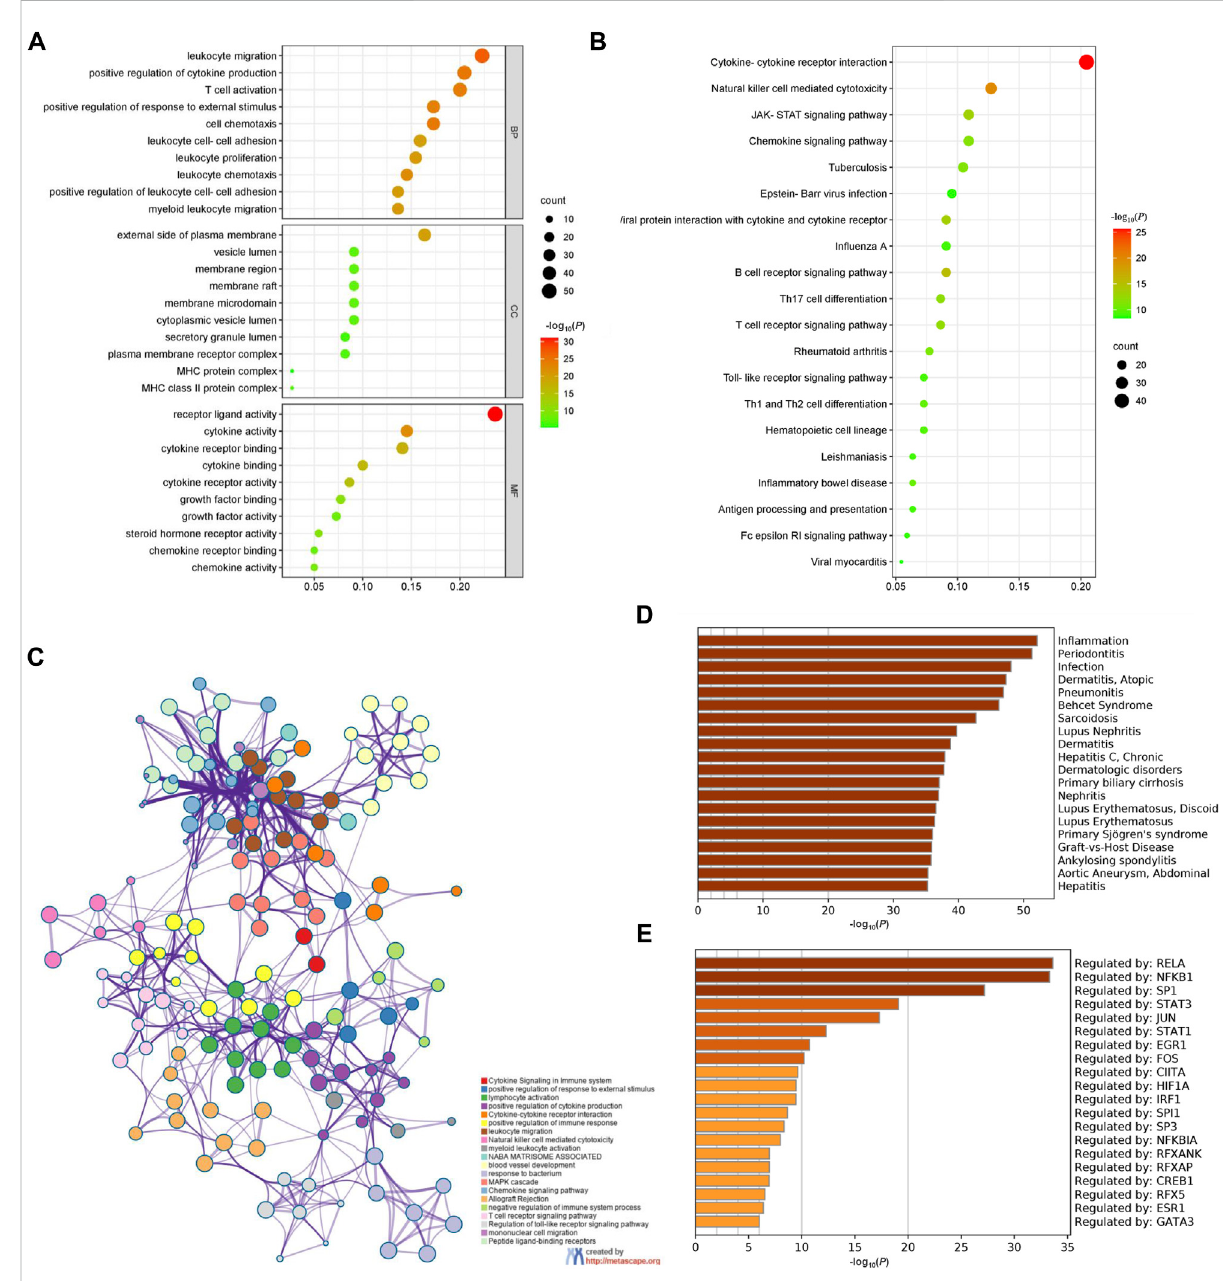
FIGURE 5 EnrichmentanalysisofDEIRGsinCAVD. (A) GOenrichmentanalysis. (B) KEGGpathwayenrichmentanalysis. (C) Thenetworkofenrichedterms andeach noderepresents an enriched term. (D) Summary ofenrichmentanalysisbasedon DisGeNET database. (E) Summaryofenrichmentanalysis based on TRRUST database. The light brown to dark brown gradient indicates an increase in -log 10 ( P ). Count: the number of genes enriched in each term; DEIRGs, differentially expressed immune related genes; GO, gene ontology; KEGG, kyoto encyclopedia of genes and